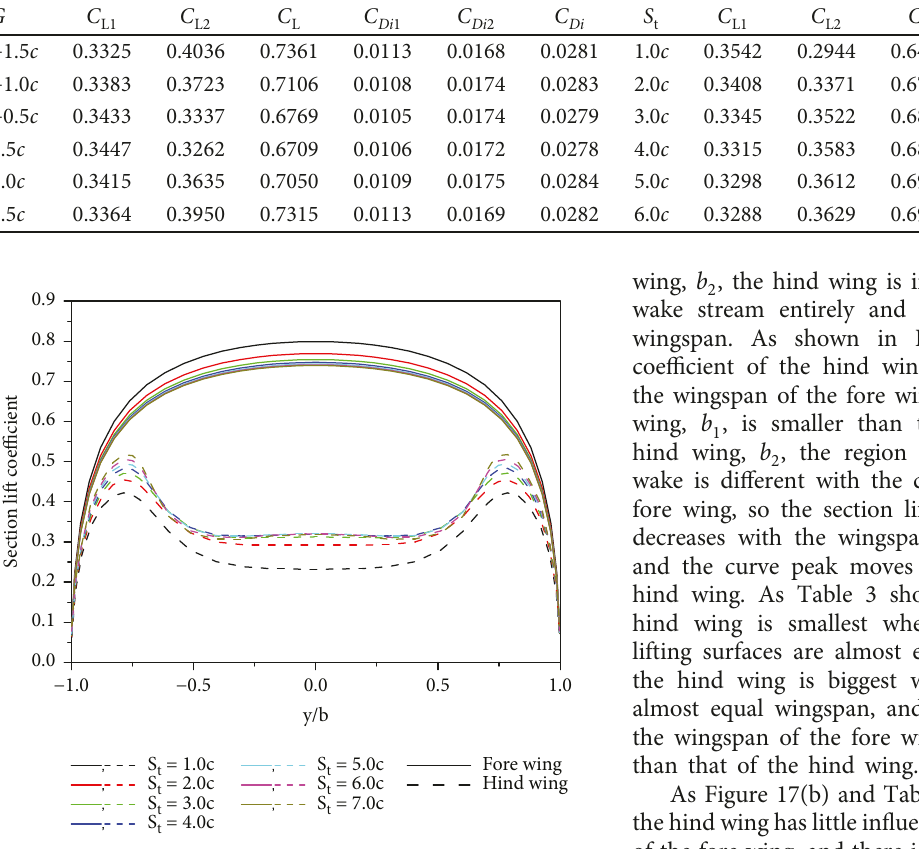
Figure 15: E ff ect of stagger on section lift coe ffi cient for tandem wing con fi